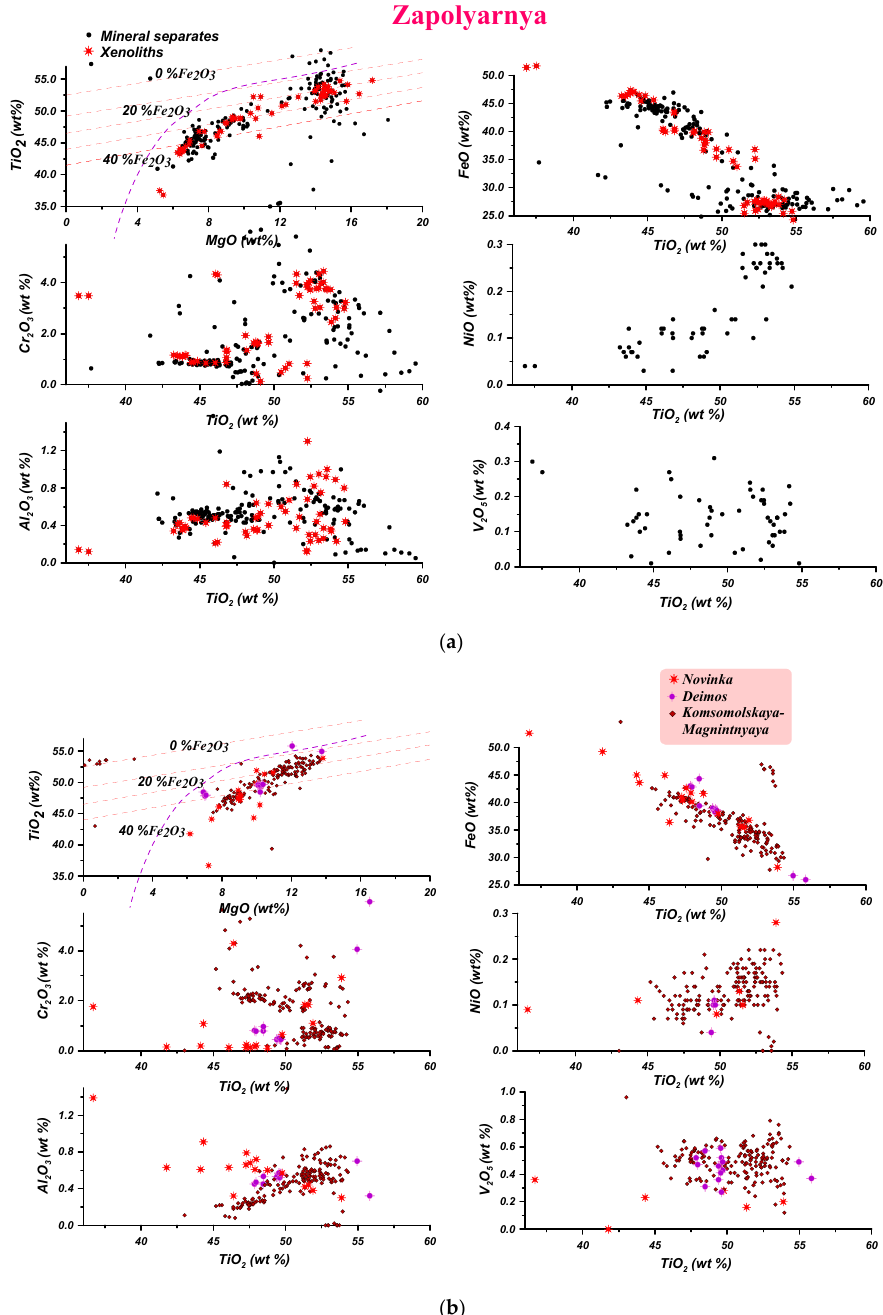
Figure 7. Compositions of ilmenites from Upper Muna field. ( a ) Zapolyarnaya; ( b ) Novinka; Deimos, and Komsomolskaya-Magnitnaya. Data for Novinka, Deimos, and Komsomolskaya-Magnitnaya are partly published [12]. Red dashed lines are isolines of Fe 2 O 3, and the dashed curve separates the values typical of the kimberlitic ilmenites according to